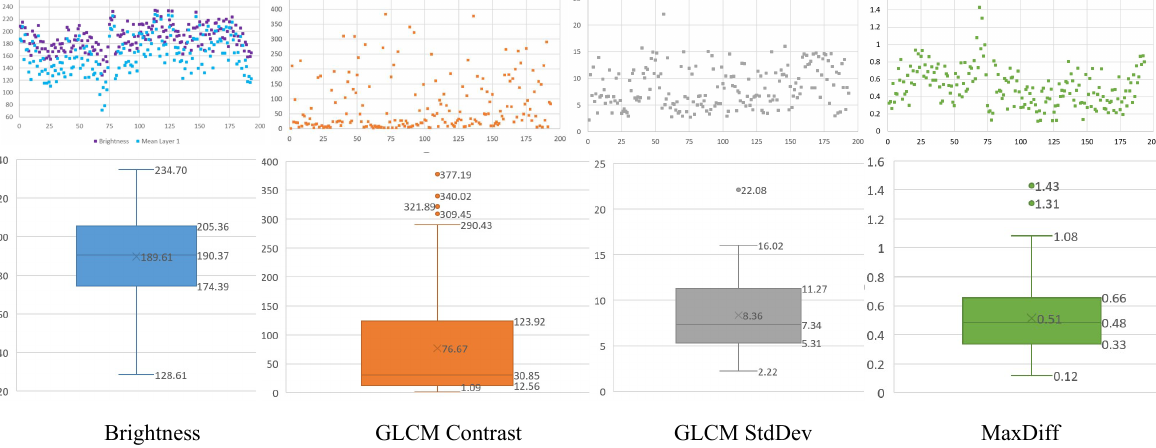
Figure 6. Scatter plots and Boxplots of Road objects